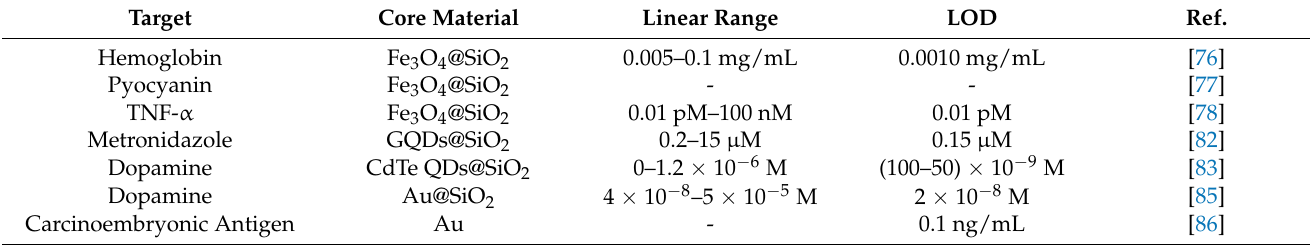
Table 2. Summary of the presented